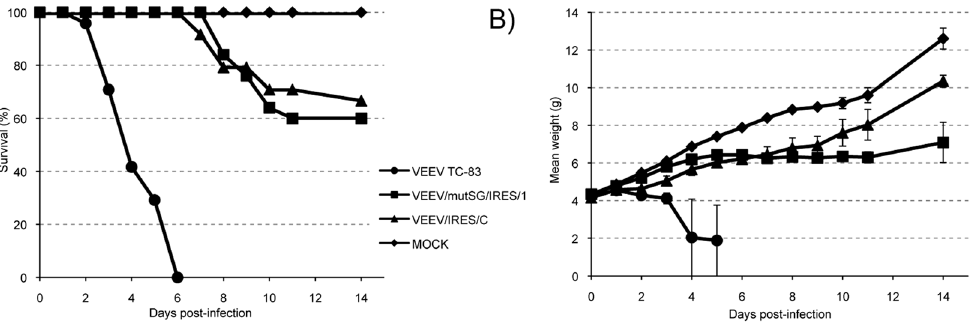
Figure 7. Neurovirulence in 6-day-old mice following IC injection of VEEV TC-83 and IRES-based viruses. Animals received 1 6 10 6 PFU of indicated viruses, and were monitored for survival (A) and weight change (B) for 2 weeks, with no deaths recorded after day 14